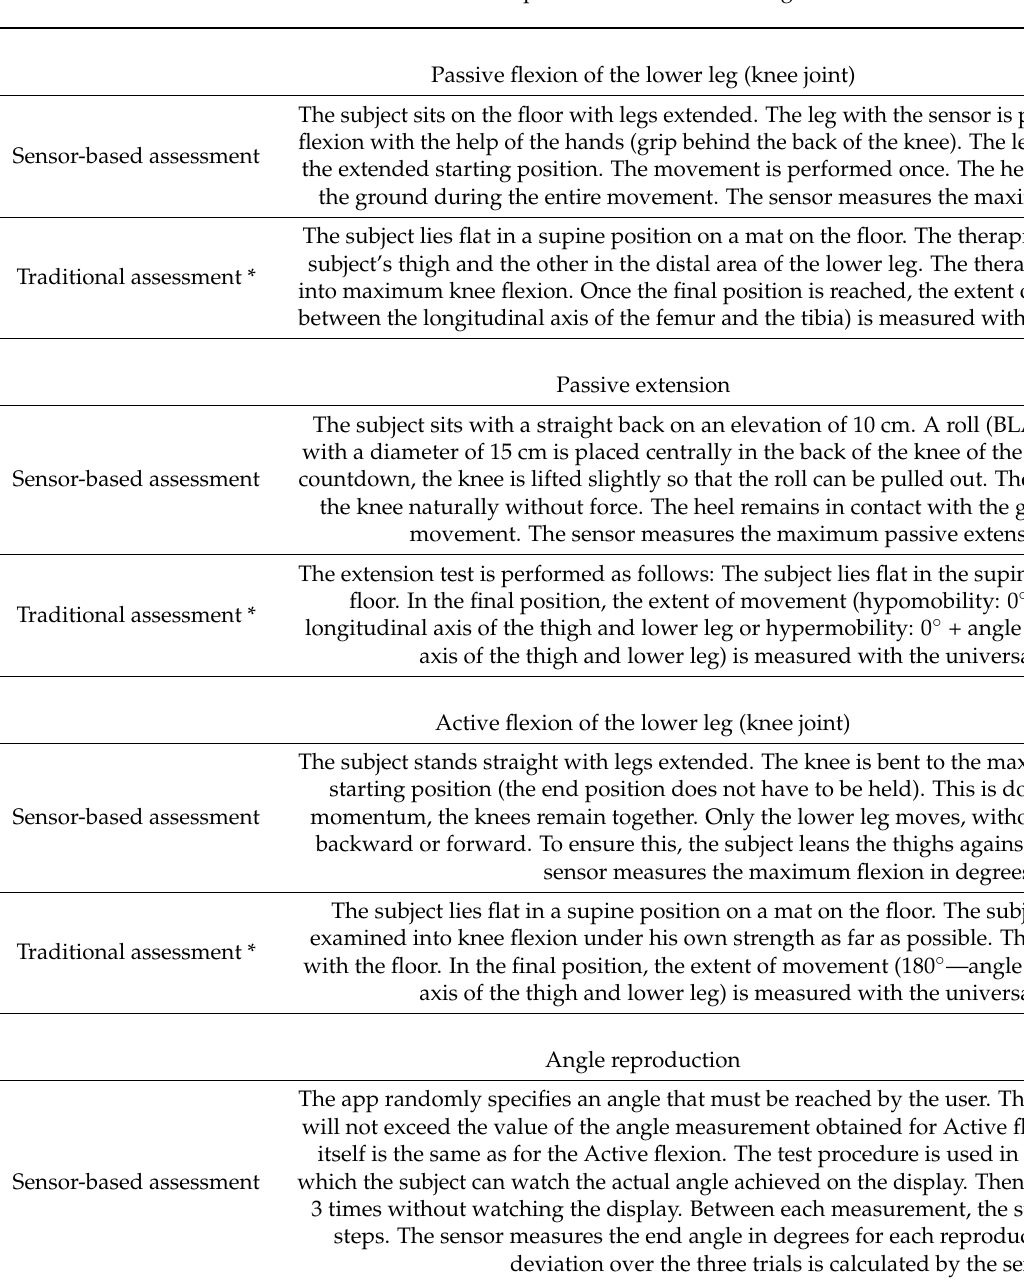
Table 1. Assessment procedures used for the eight